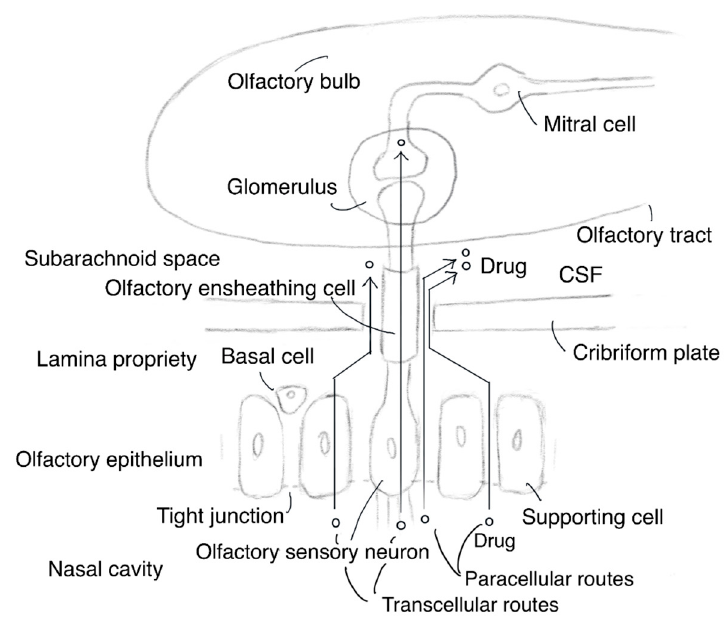
Figure 2. Structure of the olfactory epithelium and molecular distribution pathways. CSF stands for cerebrospinal fluid.